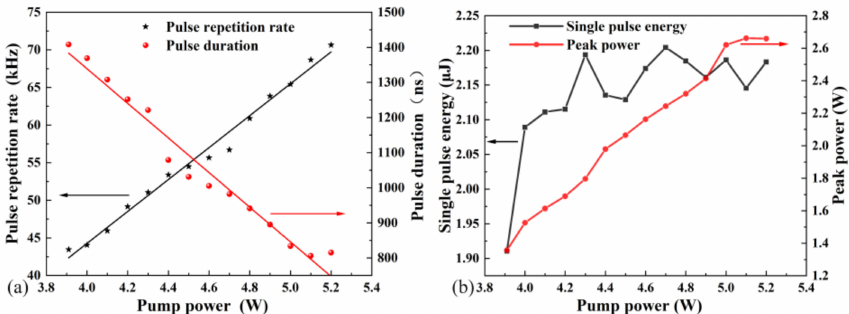
Figure 4. ( a ) Pulse repetition rate frequency and pulse duration of the PQSL. ( b ) Single pulse energy and peak power of the PQSL.